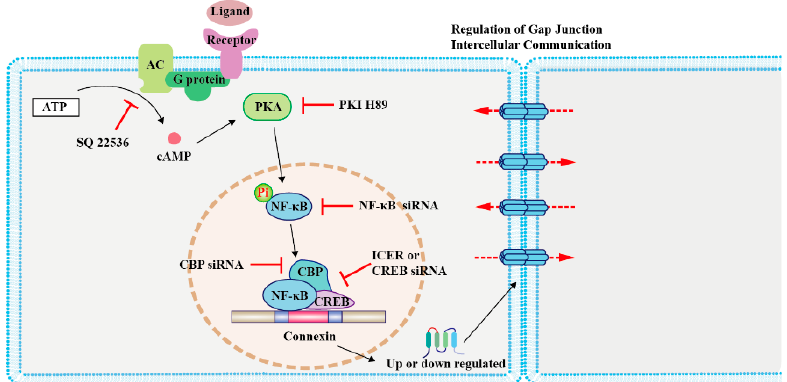
Figure 1. Regulation of connexin (Cx) expression by cAMP/PKA signaling in modulating cancer cell growth and primary cancer progression. The schematic illustrates the mechanism involved in the cAMP signaling-mediated regulation of Cx levels. Activation of the G-protein-coupled receptor on the cell membrane by ligands leads to cAMP synthesis by AC. cAMP diffuses into the cell and activates its effector protein PKA, which phosphorylates NF- κ B. Subsequently, NF- κ B, CBP, and CREB form a complex to regulate the transcription of Cxs [25,42–44]. Abbreviations: AC, adenylyl cyclase; PKA, protein kinase A; NF- κ B, nuclear factor kappa-B; CBP, CREB-binding protein; CREB, cAMP response element-binding protein; PKI, PKA inhibitor; and ICER, inducible cAMP early repressor